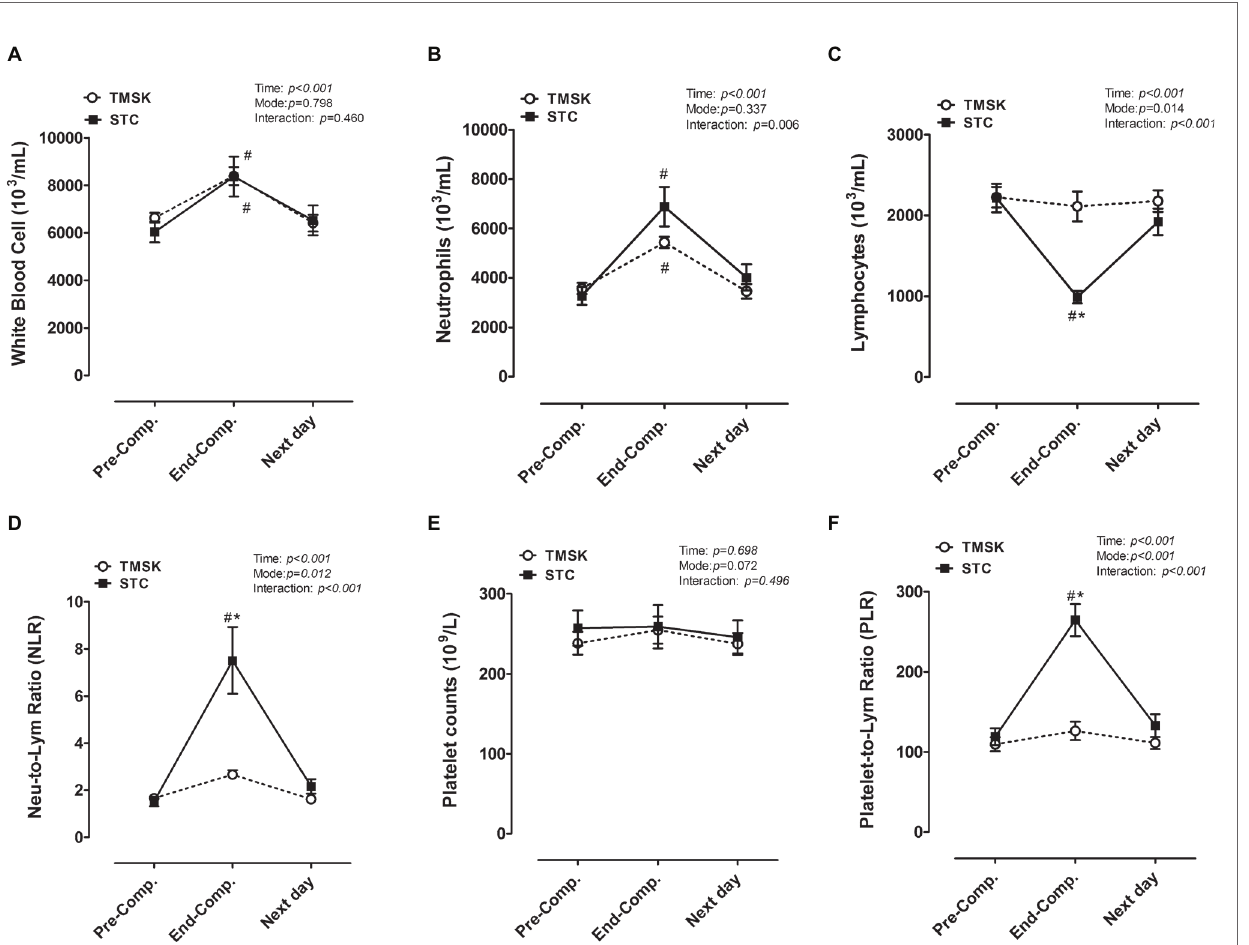
FIGURE 4 | The responses of hematological profiles (A-C,E) and systemic inflammatory biomarkers (D,F) during real combat match and simulation kicking exercise. # denotes a significant difference compared to baseline values ( p < 0.05); * denotes significant difference between TMSK and STC ( p < 0.05). TMSK: TKD-match simulated kicks; STC: simulated TKD